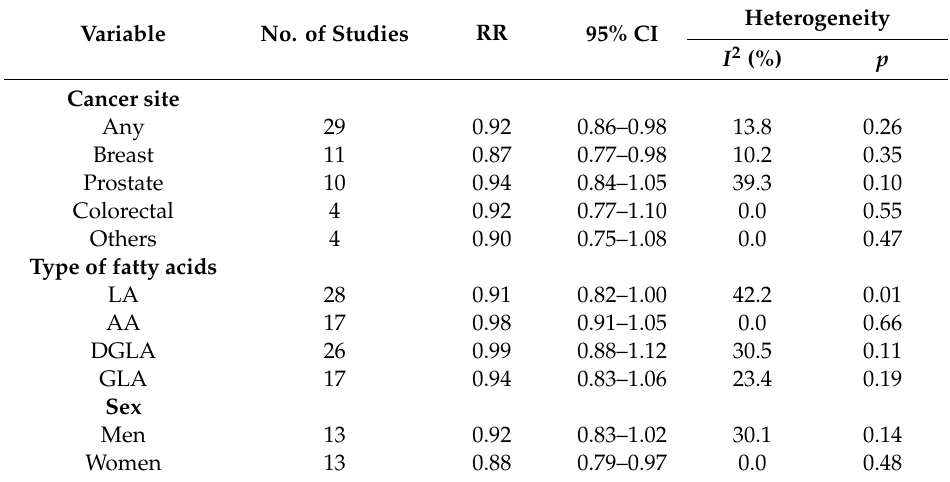
Table 2. Summary of pooled relative risks (RR) of cancer risk for blood levels of n-6